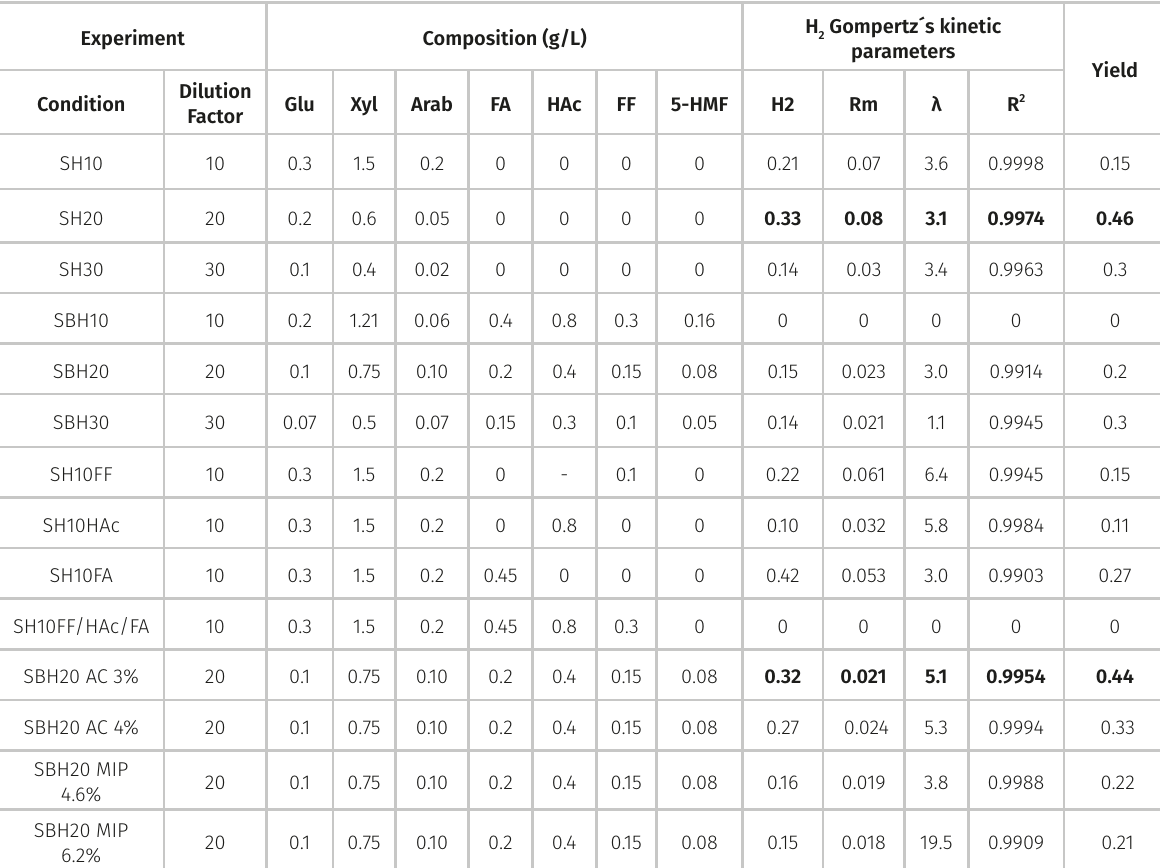
Table I. Experimental conditions of each experiment and Gompertz parameters for hydrogen production by Enterobacter sp.